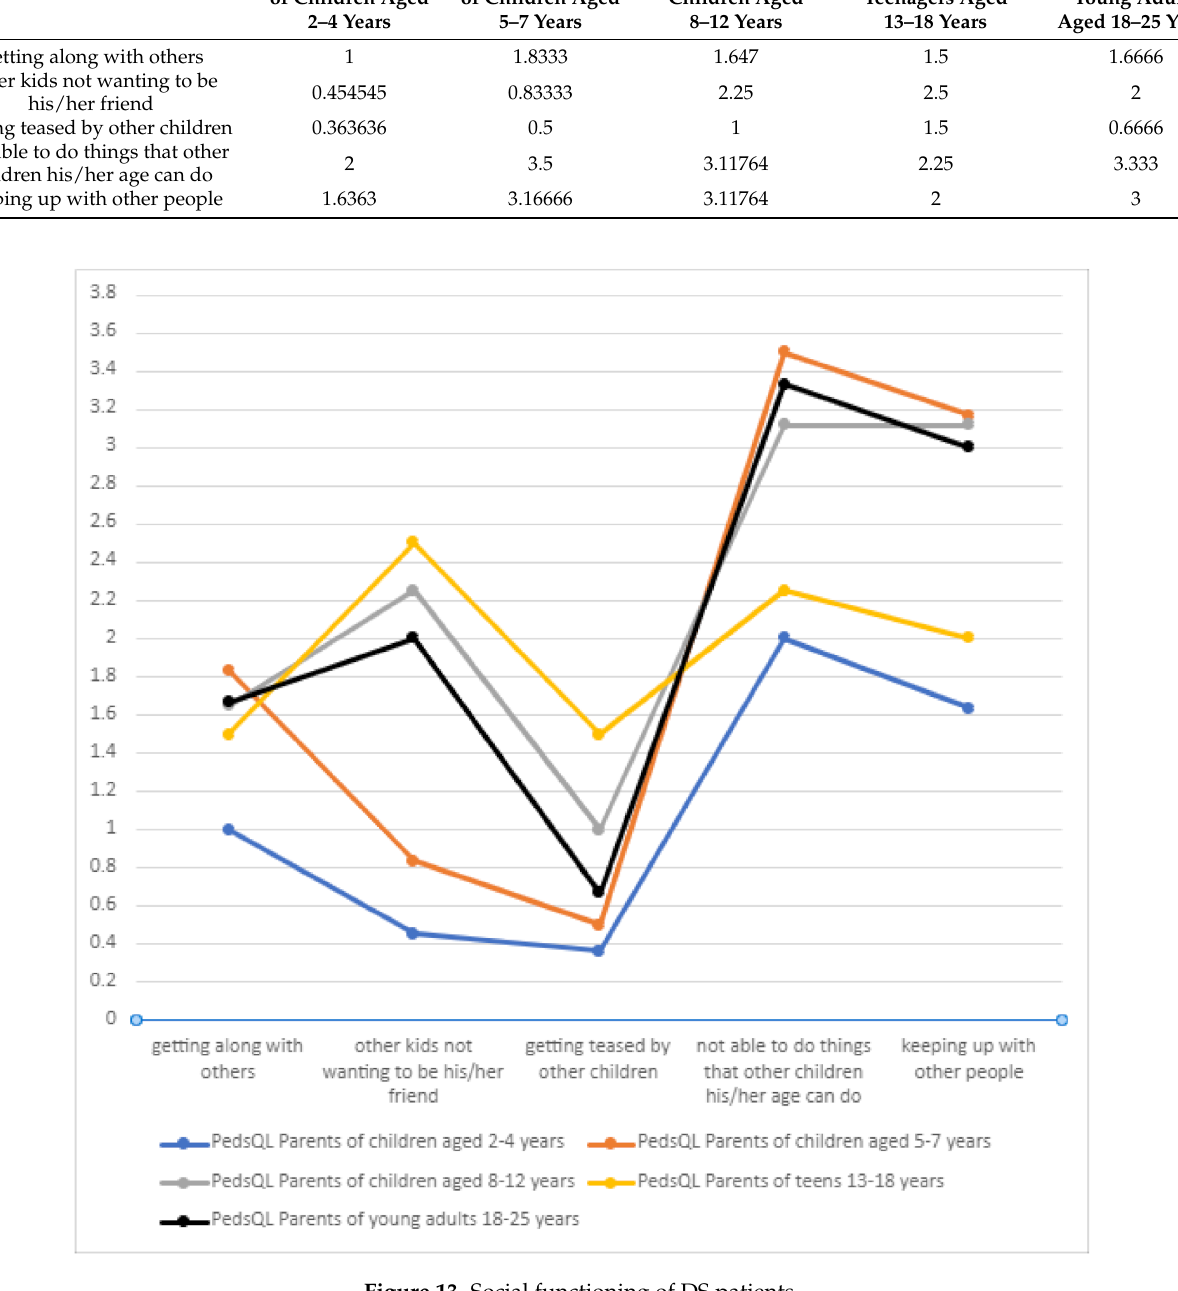
Table 8. School functioning of patients with